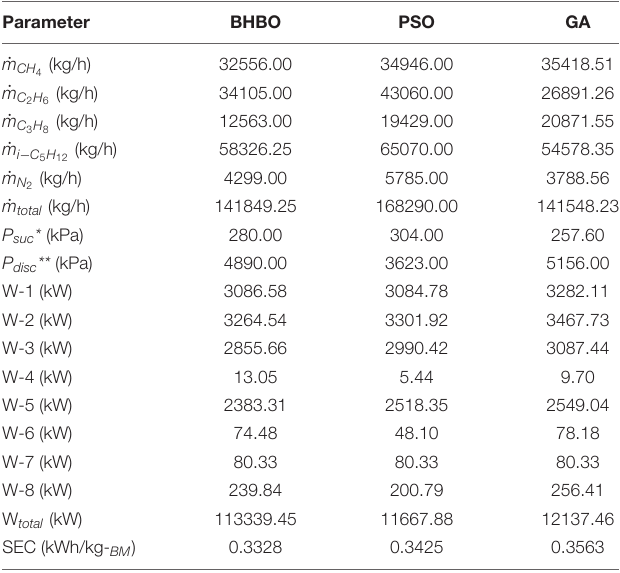
TABLE 5 | The decision variables along with the power consumption of modified case 2 optimized by three algorithms. Parameter BHBO PSO